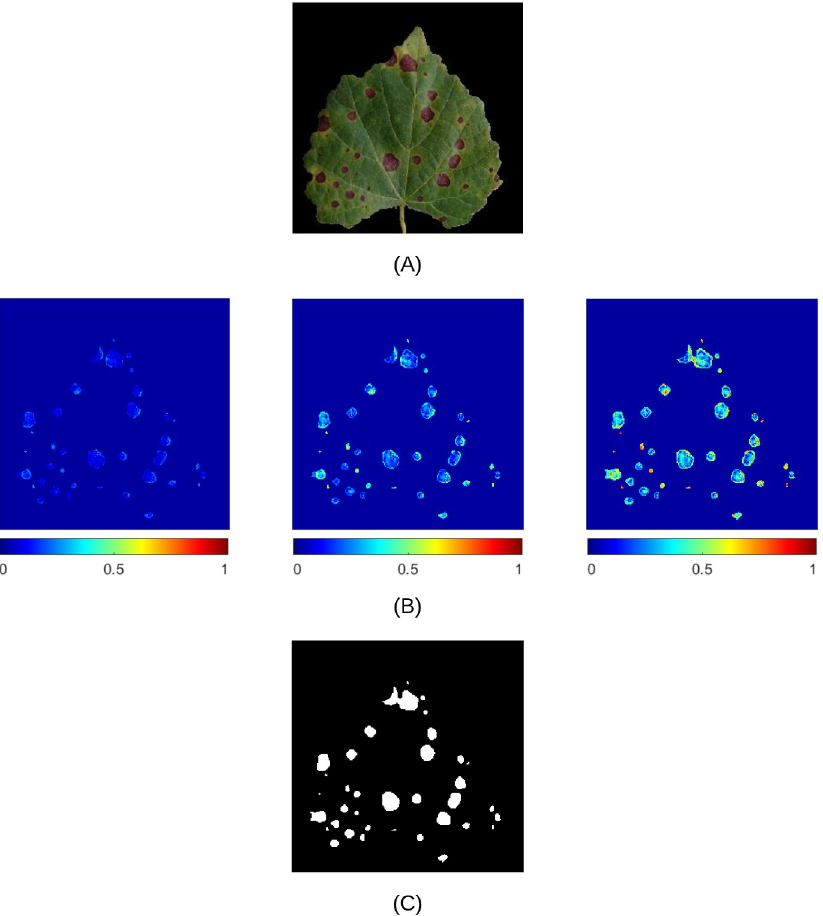
Fig 3. Dynamic algorithm behaviour. (A) Input image representing a grape leaf affected by Black Rot disease. (B) The resulting image from the application of the dynamic algorithm (representation of the pixels modified by the iterative procedure during the transient state until the steady-state condition has been reached). (C) Final result after binarisation.